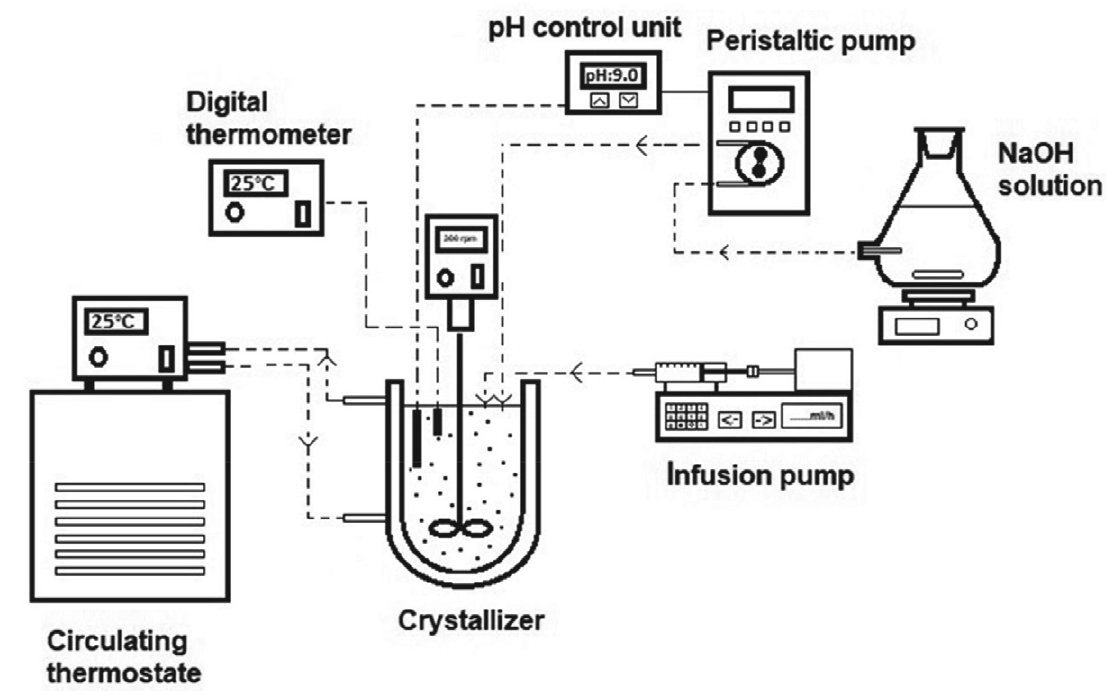
Figure 1. Experimental